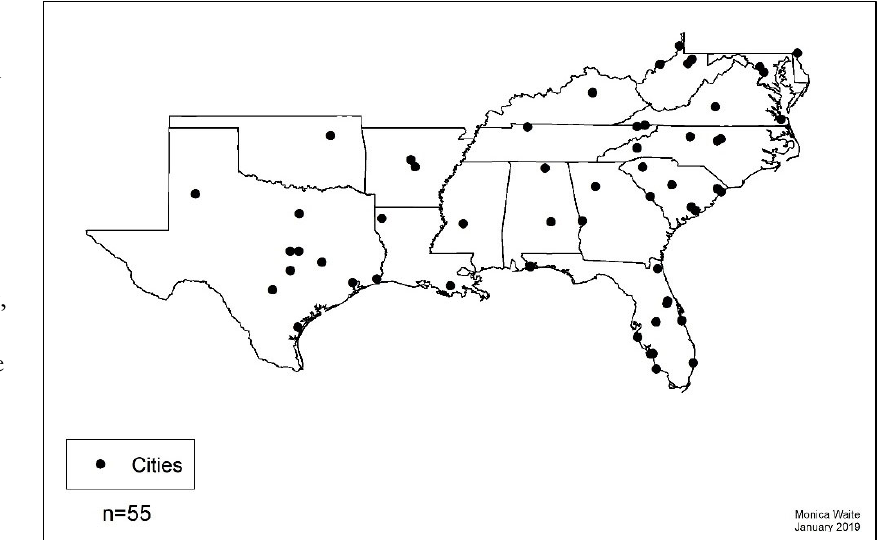
Figure 1. Southern Cities Responding to the Urban Agriculture Survey, Mapped by States in the 16-State Southern Region